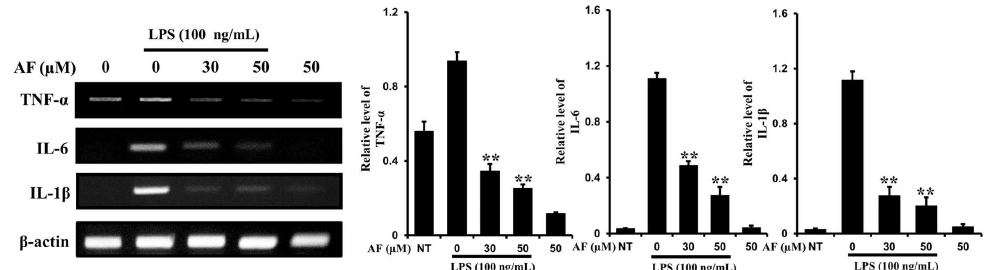
Fig 4. Effects of AF on the levels of LPS-induced cytokines TNF- α , IL-6, and IL-1 β in RAW 264.7 macrophages. The mRNA levels of TNF- α , IL-6, and IL-1 β were determinedby RT-PCR in cells treated with 100 ng/mL of LPS only or with 1–50 μ M of AF for 24 h. Band density in Fig 4 (versus β -Actin) is indicatedas the mean ± SEM of three independentexperiments. ** p < 0.01 indicates significantdifferences from the LPS alone- treated